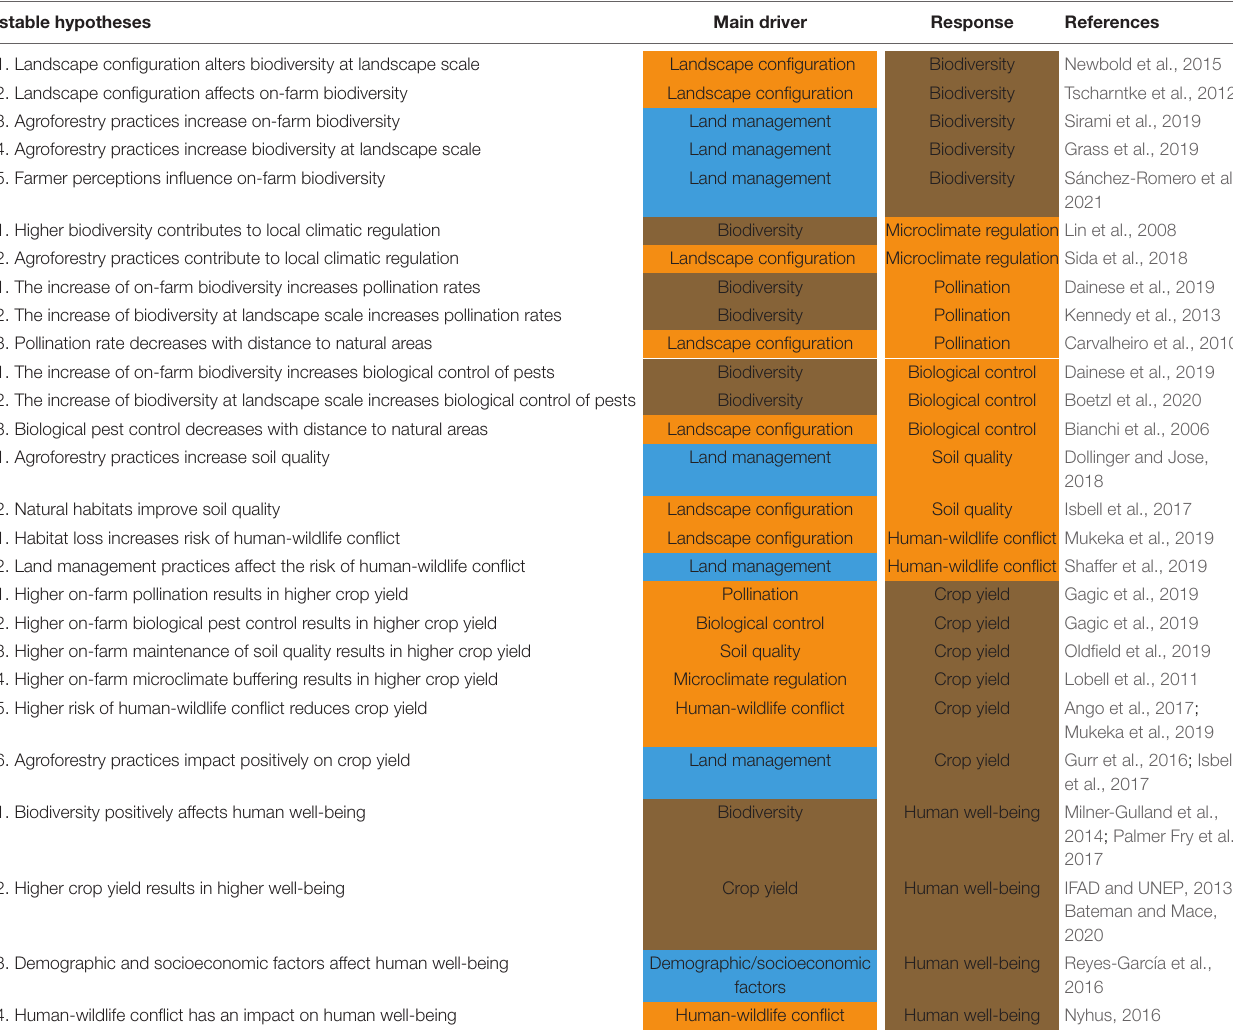
TABLE 1 | Overview of testable hypotheses resulting from system model pathways (their starting and finish nodes, i.e., main direct driver and response) for analysing multiple outcomes in forest-agricultural